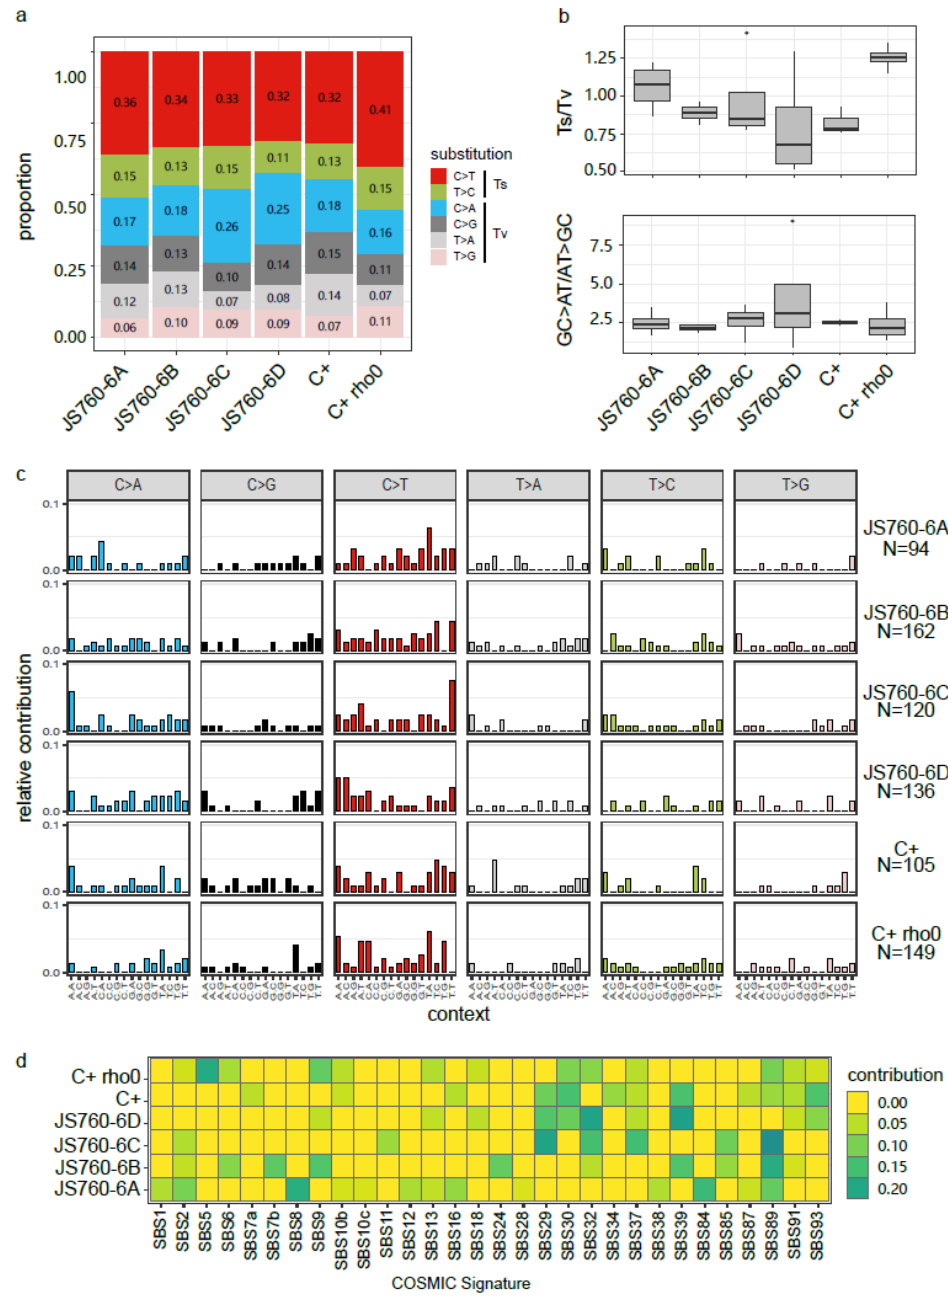
Figure 2. Mutation spectra comparison among the six strains. ( a ) Proportion of six types of substitutions. ( b ) Transition/Transversion ratio and G/C to A/T substitution bias. ( c ) SNV profiles within a trinucleotide context. The number of SNVs used for the analysis are 94, 162, 120, 136, 105, and 149 for JS760-6A, 6B, 6C, 6D, C+, and C+ rho, respectively. ( d ) The SNV profiles were fit to the COSMIC signature (https://cancer.sanger.ac.uk/cosmic/signatures, accessed on 13 December 2022) and the relative contributions of SBS (single base substitution) signatures are shown. The genotypes of the six strains are as follows: JS760-6A ( MRPL25 + atp3 G348T ), JS760-6B ( mrpl25 Δ ATP3 + ), JS760-6C ( MRPL25 + ATP3 + ), JS760-6D ( mrpl25 Δ atp3 G348T ), C+ (positive control), C+ rho0 (negative control).